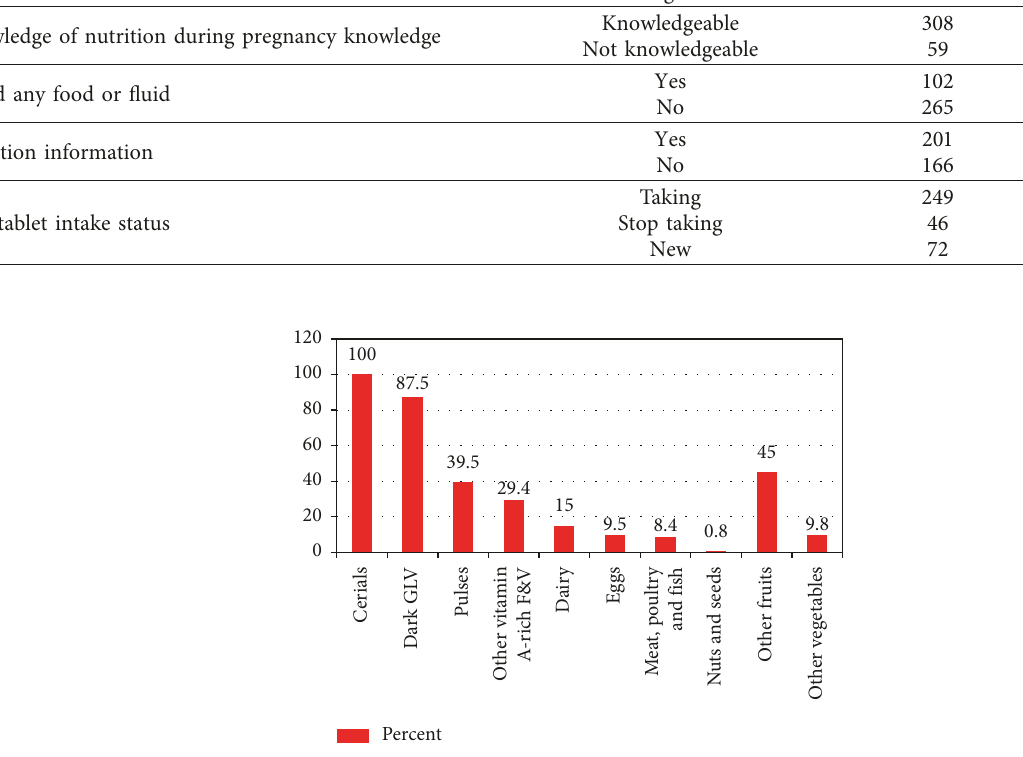
Figure 2: Food groups consumed by pregnant mothers in Arba Minch Zuria district in February 2020.